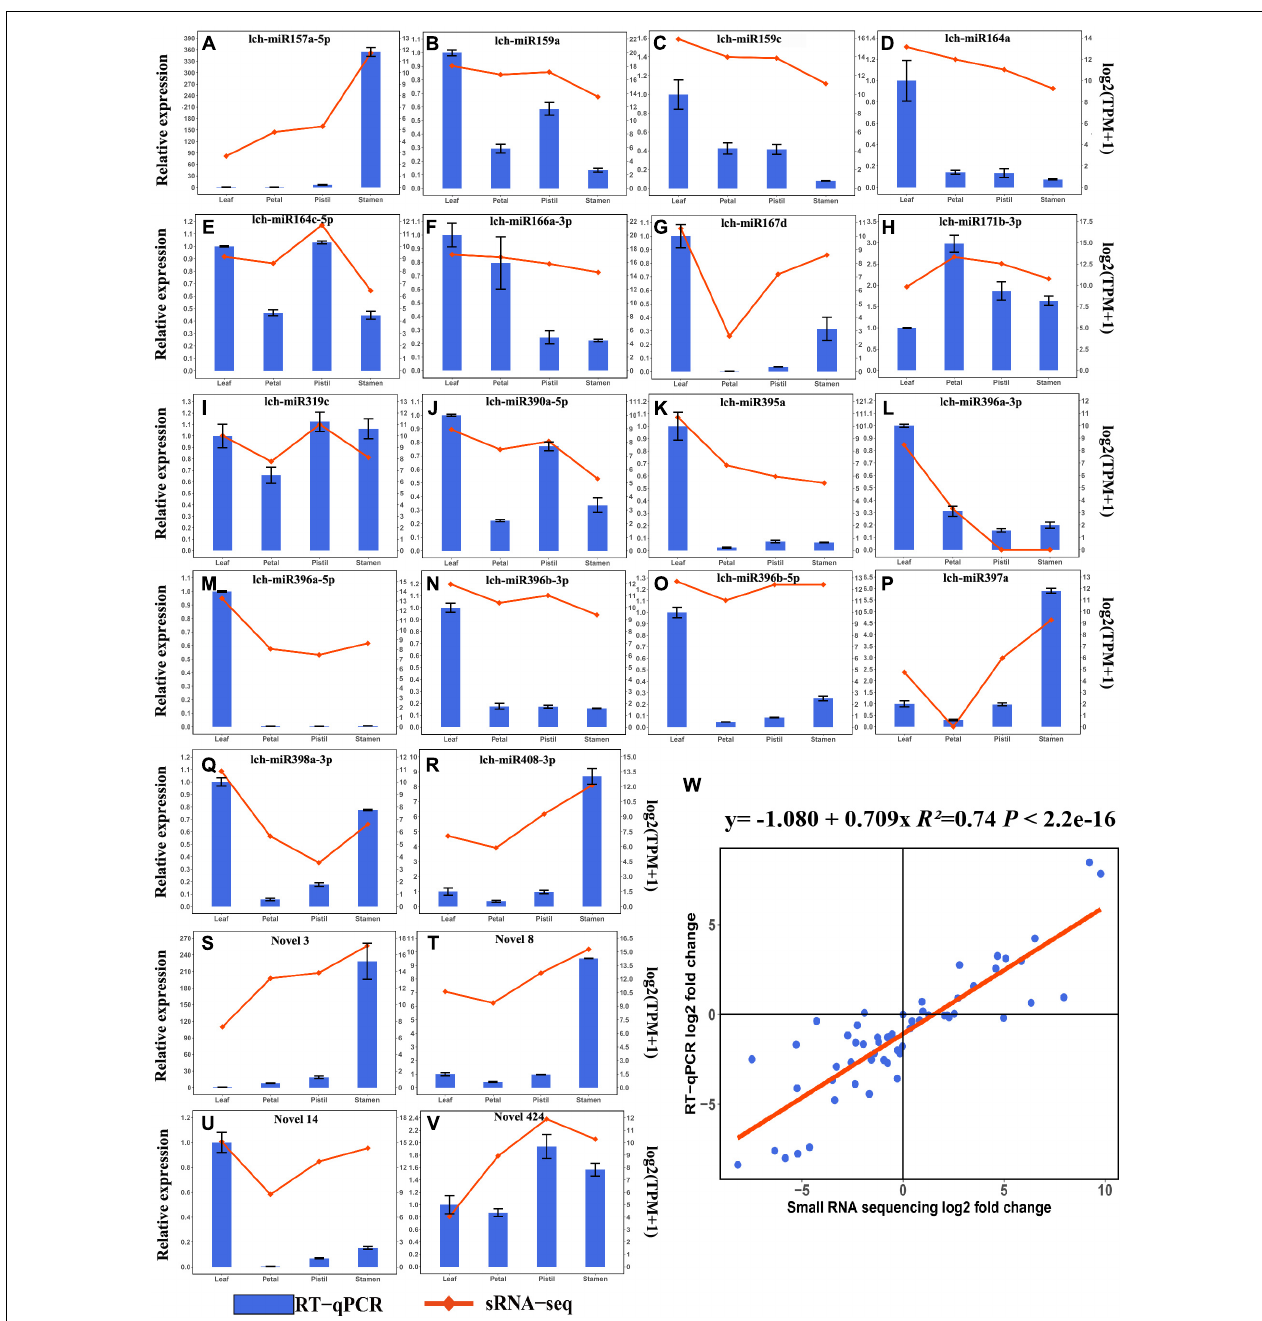
FIGURE 4 | RT-qPCR validation of DEMs. (A–V) Relative expression analysis and expression levels detected by small RNA sequencing of lch-miR157a-5p, lch-miR159a, lch-miR159c, lch-miR164a, lch-miR164c-5p, lch-miR166a-3p, lch-miR167d, lch-miR171b-3p, lch-miR319c, lch-miR390a-5p, lch-miR395a, lch-miR396a-3p, lch-miR396a-5p, lch-miR396b-3p, lch-miR396b-5p, lch-miR397a, lch-miR398a-3p, lch-miR408-3p, Novel3, Novel8, Novel14, and Novel424, respectively. The relative expression levels and expression levels detected by small RNA sequencing of miRNAs are presented as a bar plot and line plot, respectively. (W) Correlation analysis between the relative expression analysis and small RNA sequencing results of 22